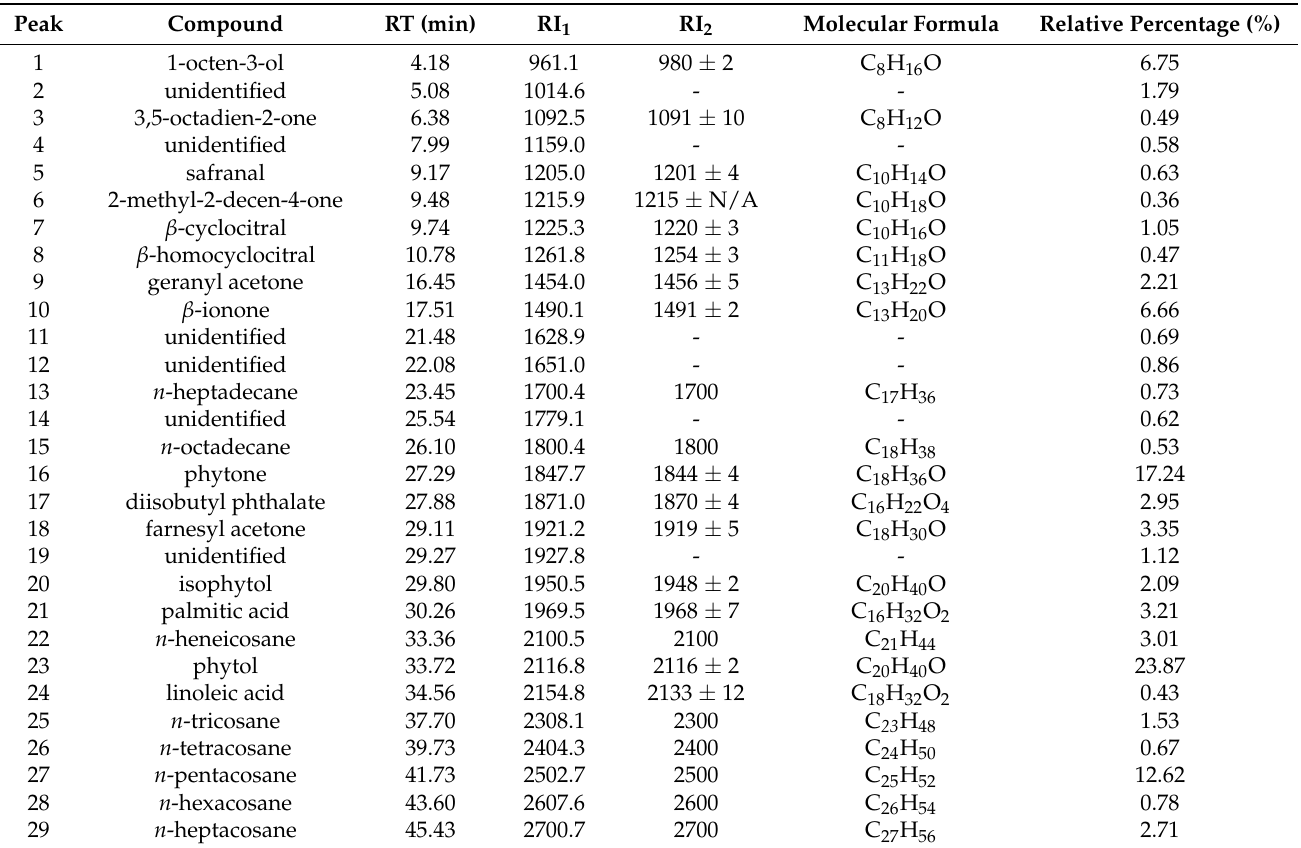
Table 5. Chemical compositions of Polygonum orientale essential